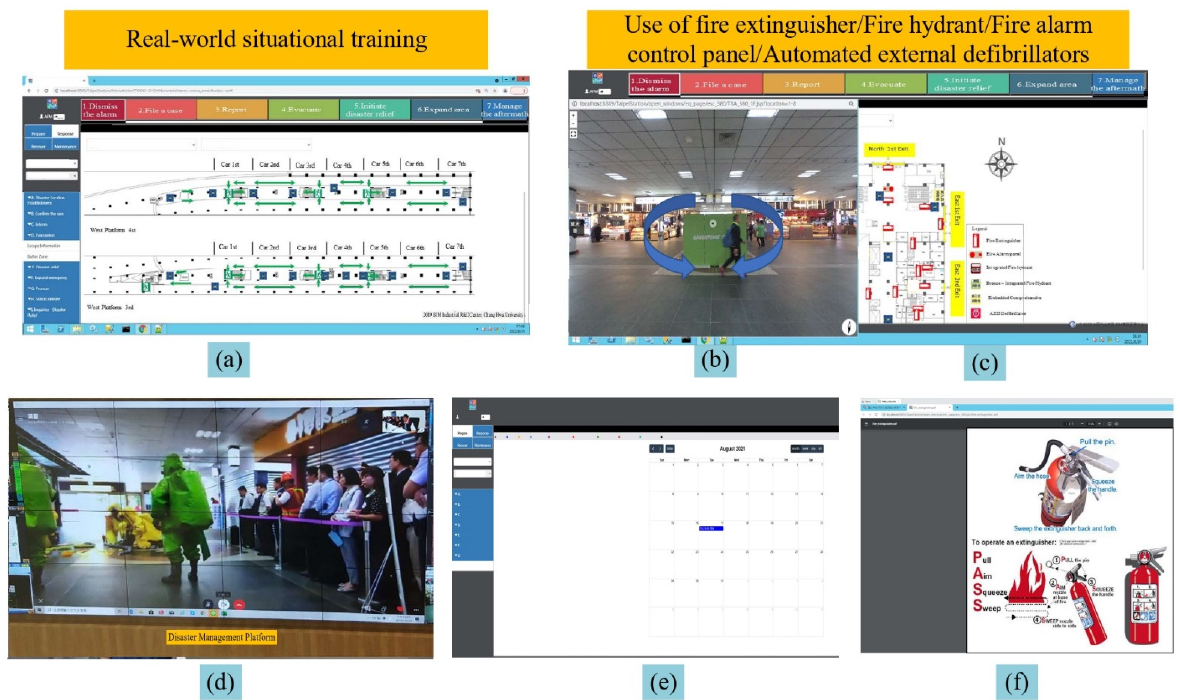
Figure 6. Pre-disaster (usual) preparedness: real-world situational training. (Source: Research Data). ( a ) Exit; ( b ) 360 degrees display screen; ( c ) Disaster relief equipment; ( d ) Drill simulation; ( e ) Drill time announcement; ( f ) Use of disaster relief equipment.